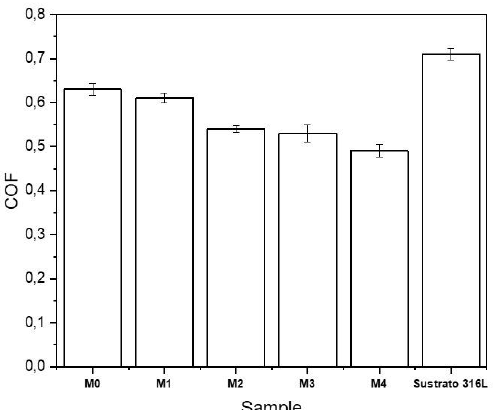
Figure 7. Coefficient of friction of the coatings and the substrate.